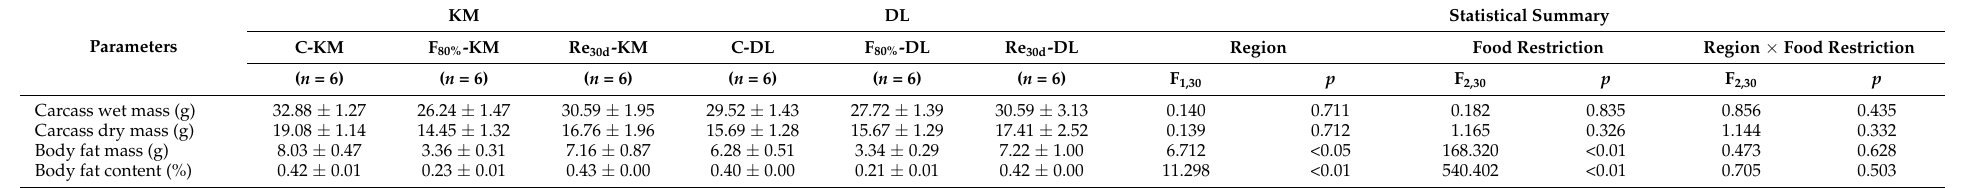
Table 3. Carcass mass, body fat mass, and content of E. miletus in different regions under food restriction.